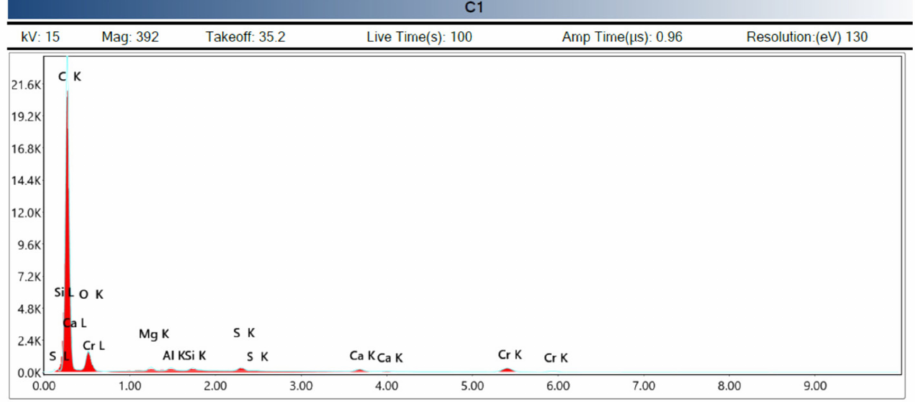
Figure 14. Out-of-range measurement spectrography of carbon fiber, calcium sulfate matrix. (Source: the author).